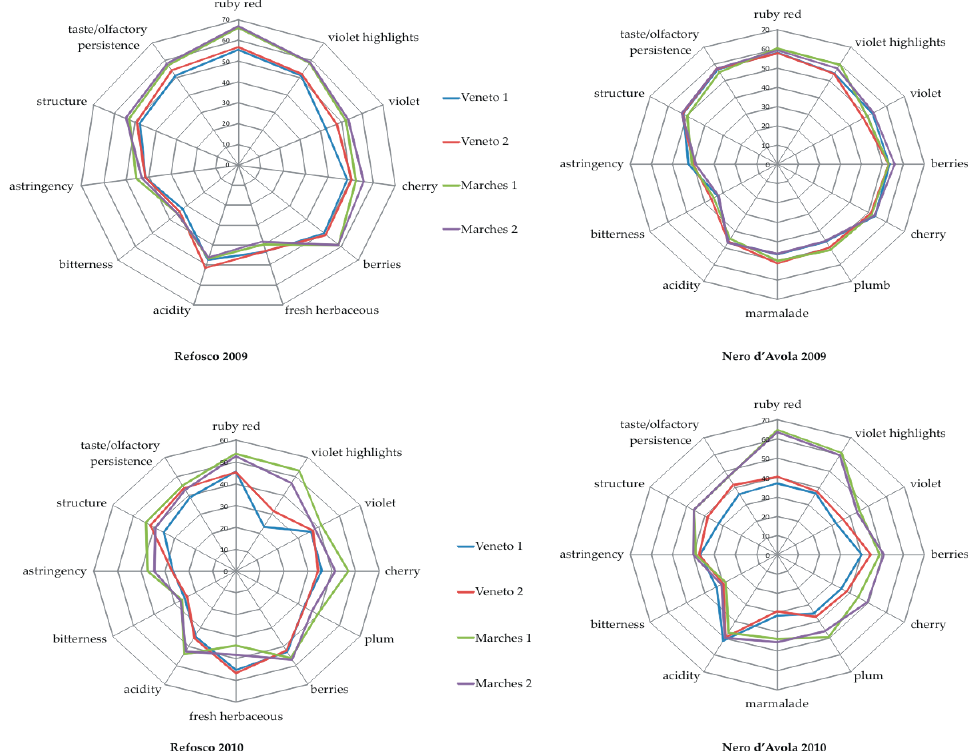
Figure 2. Sensory profiles of red wines.